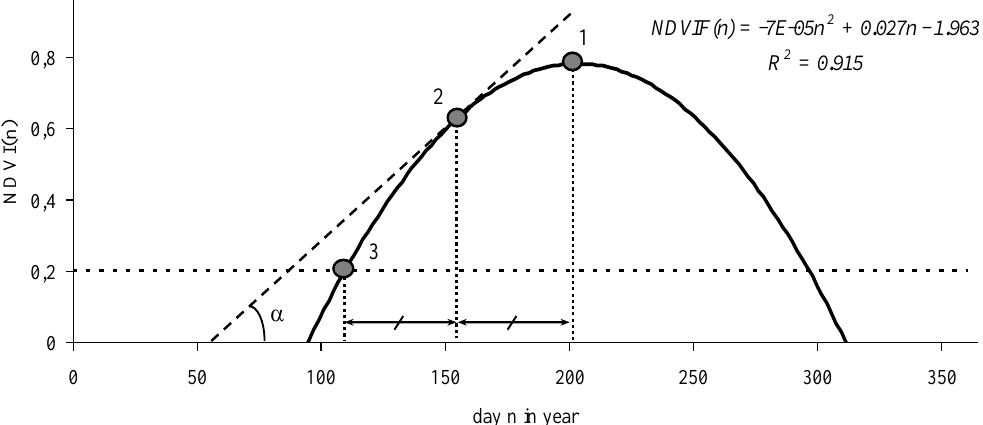
Figure 3. Procedure for recalculating of the NDVI seasonal dynamics curve. Point 1 ( n max , NDVIF max );